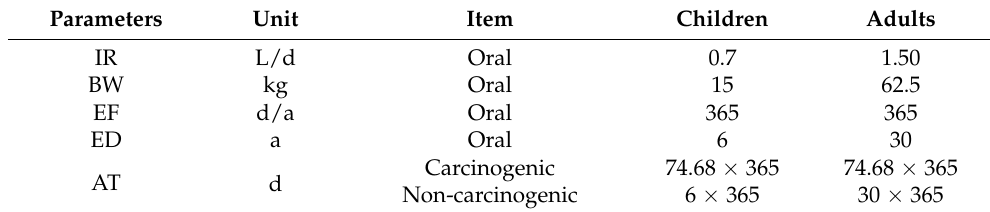
Table 1. Parameters of daily dose calculation